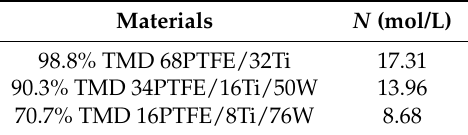
Table 5. Molar numbers of reactants per unit volume. N : molar number of the reactant per unit